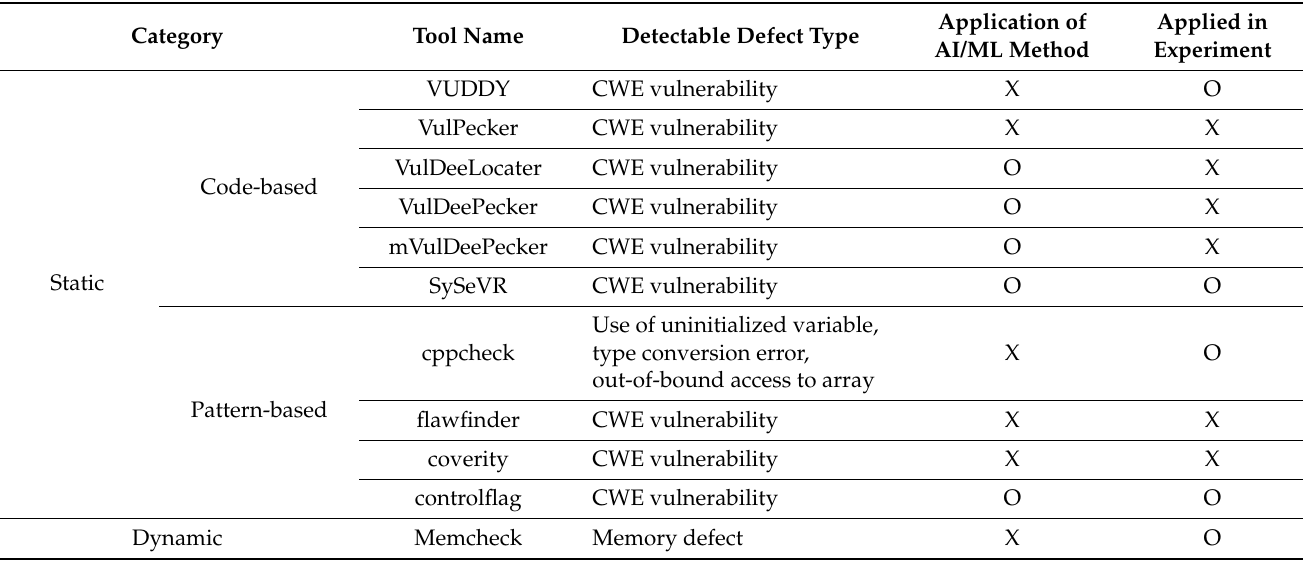
Table 4. Vulnerability detection